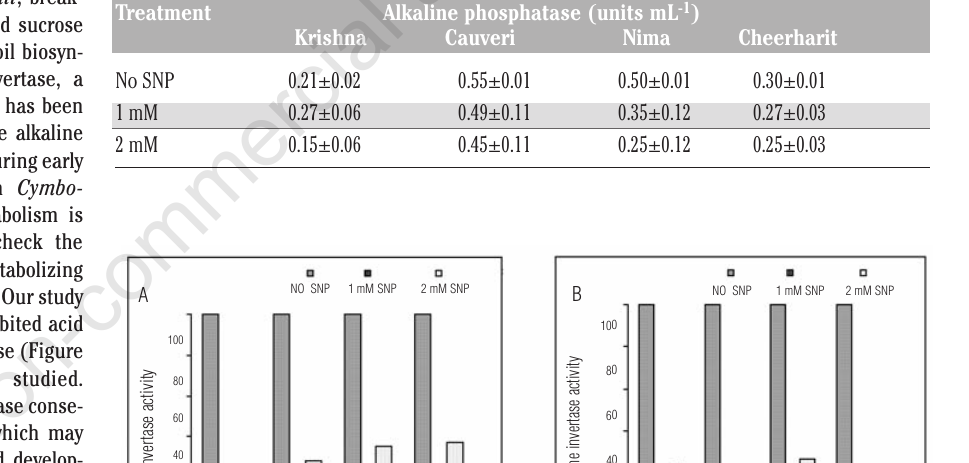
Figure 1. Effects of sodium nitroprus- side (SNP) on (A) acid invertase, (B) alkaline invertase and (C) alkaline phosphatase activities in lemongrass varieties Krishna, Cauveri, Nima and Cheerharit. Values presented in the fig- ure is mean (±SD) of three experi-